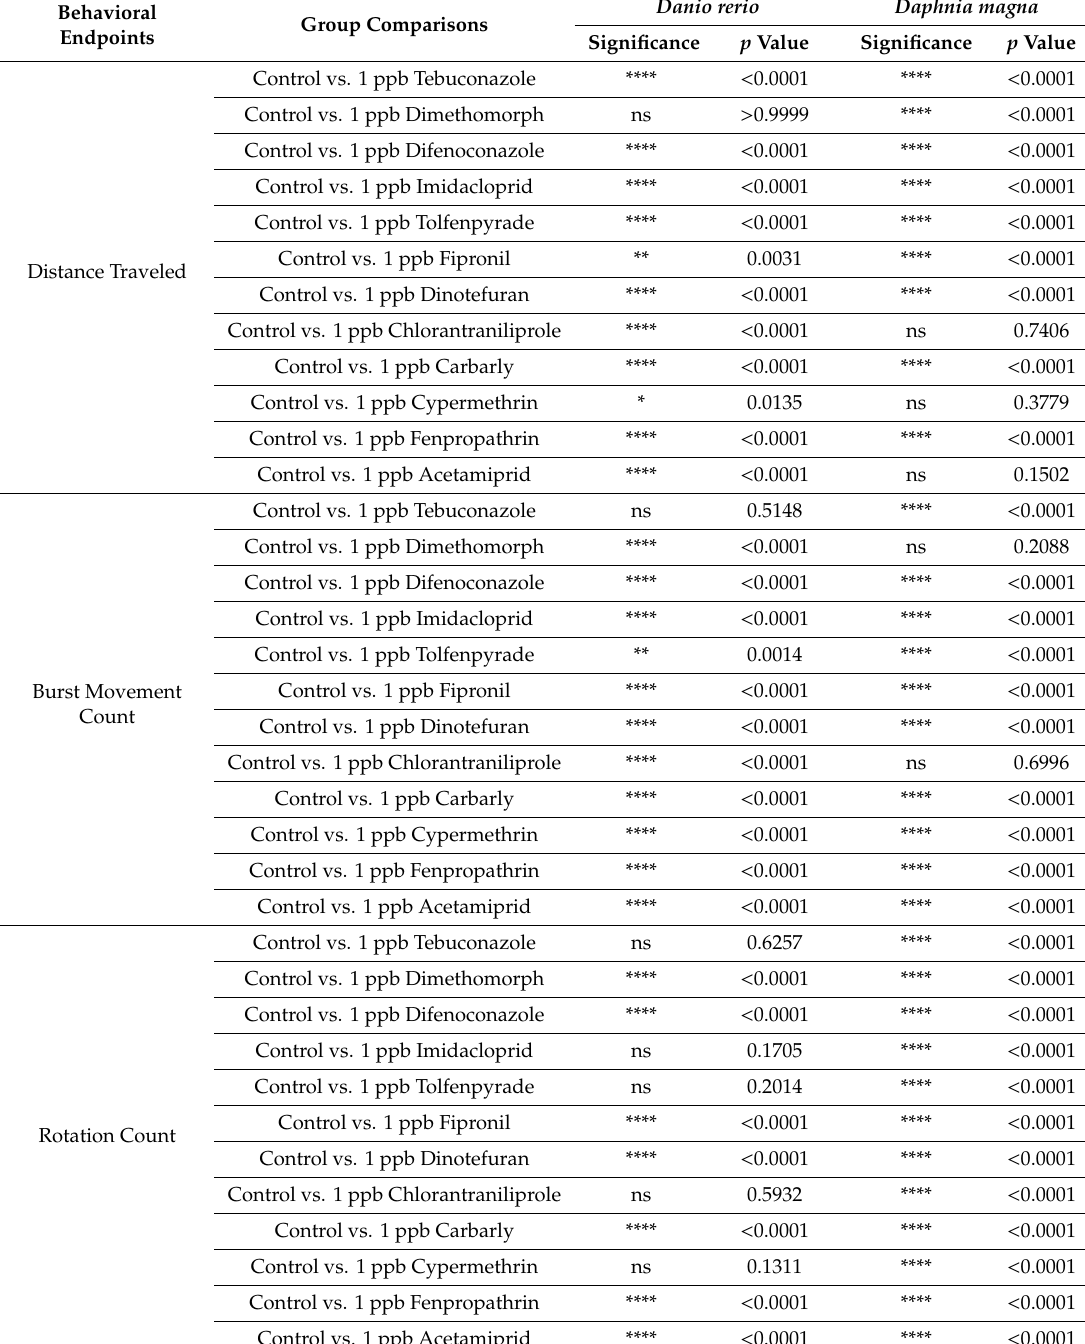
Table A2. Comparison of the light and dark mean of all behavioral endpoints throughout the 80 min by using Two-way ANOVA of both zebrafish larvae and Daphnia magna neonates. ns, no significant di ff